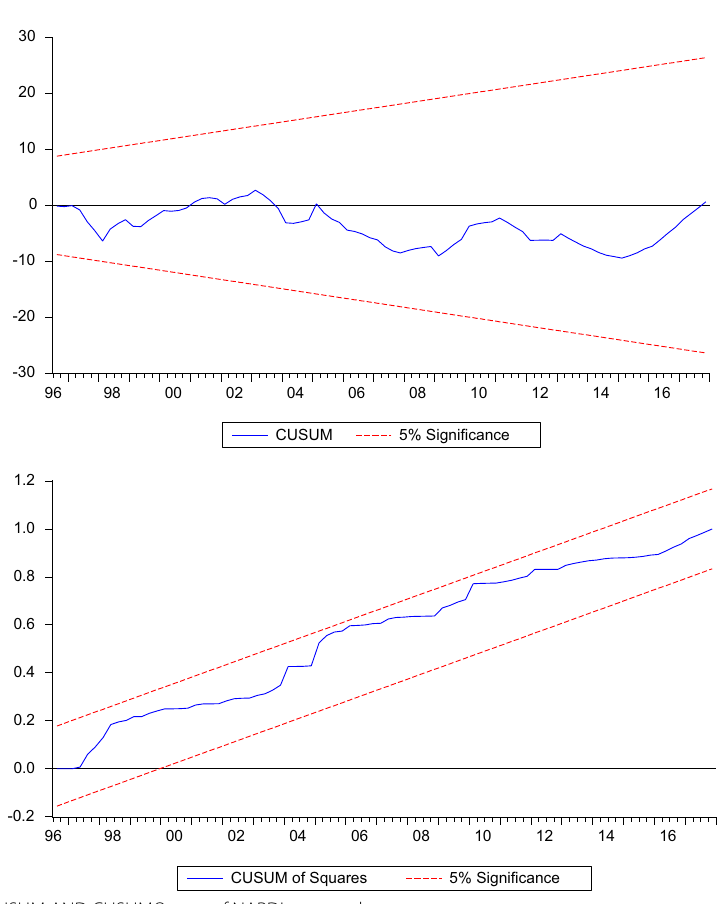
Fig. 6 CUSUM AND CUSUMQ tests of NARDL